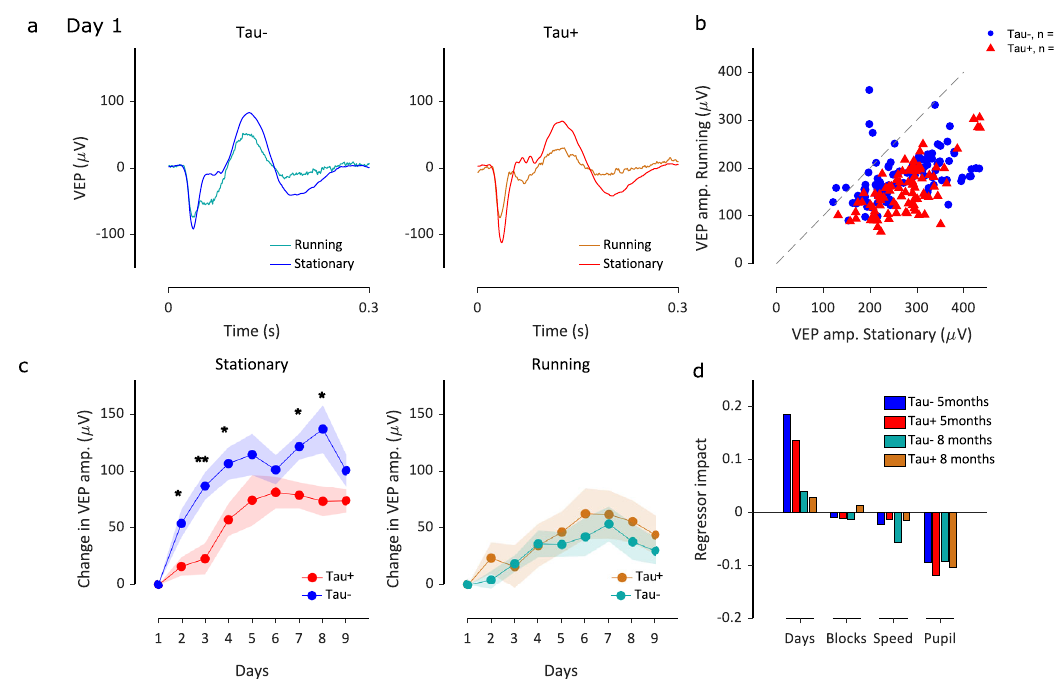
Fig. 5 Differences in visual plasticity are not due to differences in behavioural state. a VEP responses on day 1 for Tau − (blue, n = 12) and Tau + (red, n = 11) 5-month old animals calculated during running (speed > 1 cm/s) and stationary epochs. Running reduces the VEP signal for both groups of mice. b VEP amplitude during stationary versus running epochs for individual Tau − (blue circles) and Tau + (red triangles) mice. Each symbol represents the VEP amplitude on one day in one animal. c Difference in the VEP amplitude from day 1 for the familiar stimulus, for Tau − and Tau + 5-month old animals, calculated for only stationary (left) or only running (right) epochs. VEP potentiation was evident in both groups of animals for both behavioural states. Shaded area represents the mean ± SEM ( n = 12 Tau − , n = 11 Tau + ). ** p < 0.01, * p < 0.05. d We fi tted an elastic net regularisation model to predict the VEP amplitude for each animal using days, block number, movement speed, and pupil diameter as regressors. We assessed the impact of each regressor in predicting the VEP amplitude as the product between each learned weight and observed variable, divided by the predicted value across the entire regularisation path (of elastic net regression). The panel shows the average regressor impact for each phenotype at 5 and 8 months of age. The source data underlying this fi gure are available in Supplementary Data